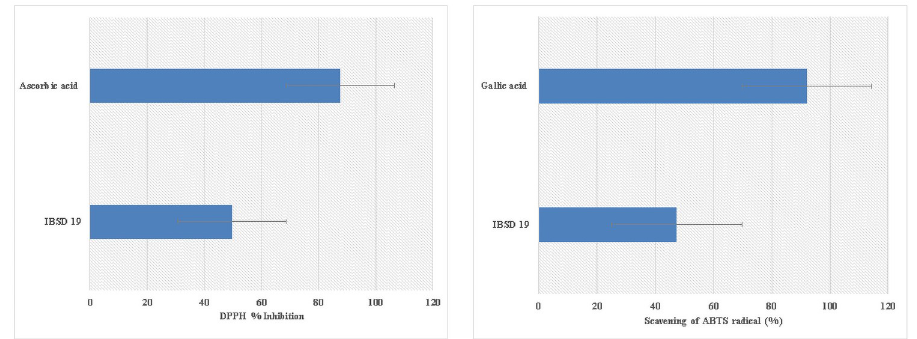
Fig 5. (A) DPPH radical scavenging activity of the extract. (B) ABTS+ radical scavenging activity of the extract. Values are mean ± SD; n =